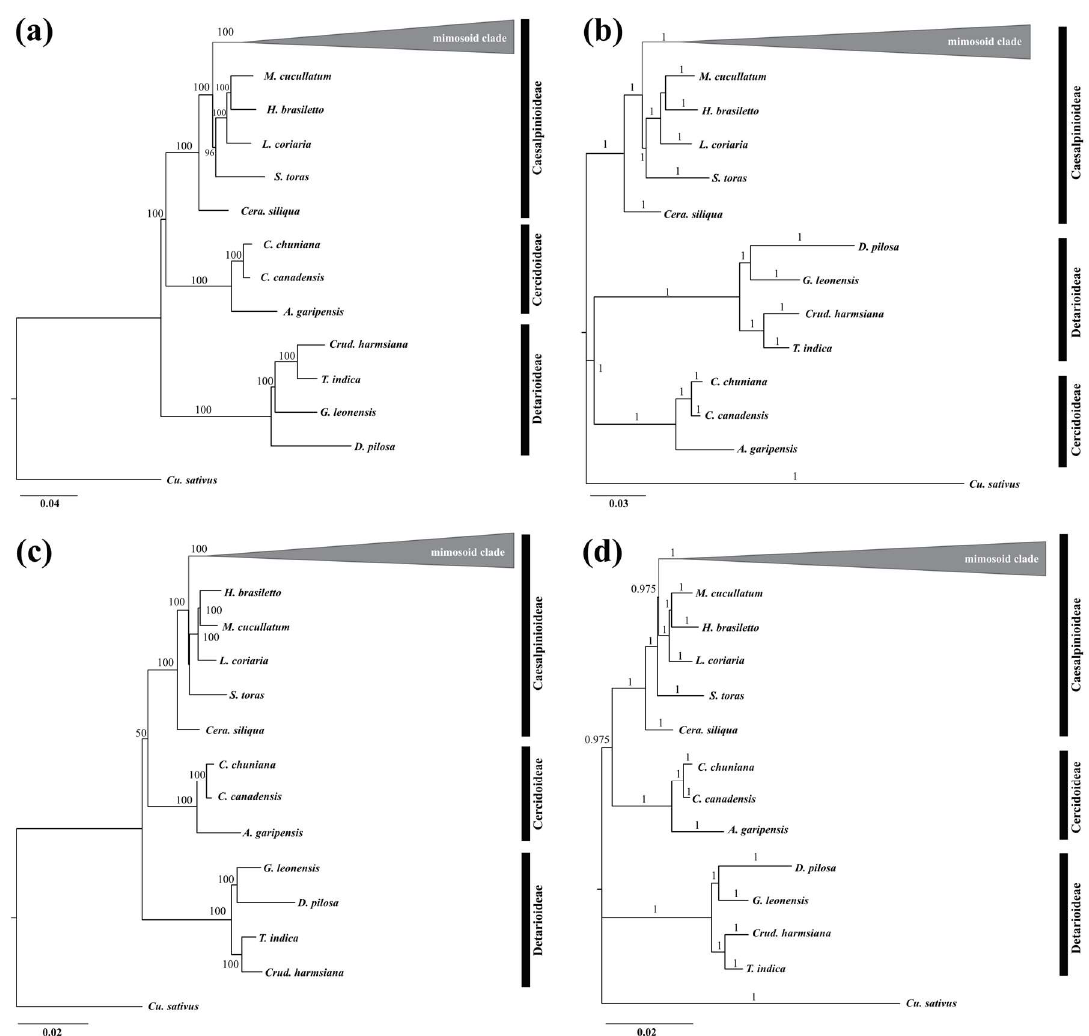
Figure 6. Phylogenetic trees of sampled species inferred from the concatenated whole cp genome sequences and 61 protein-coding genes (PCGs) in the cp genome based on maximum likelihood (ML) and Bayesian inference (BI). ( a ) ML analysis based on whole cp genome sequences; ( b ) BI analysis based on whole cp genome sequences; ( c ) ML analysis based on PCGs; ( d ) BI analysis based on PCGs. Numbers in bold above branches are bootstrap values ≥50% and Bayesian posterior probability values ≥90%.